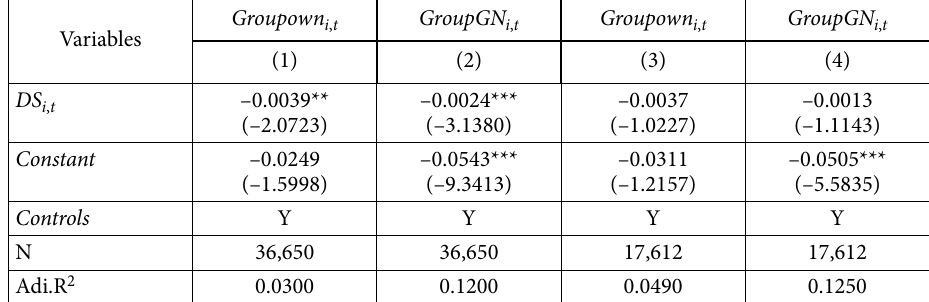
Table 8. Asymmetries in corporate strategy deviation and institutional investor recognition – regression of property rights grouping